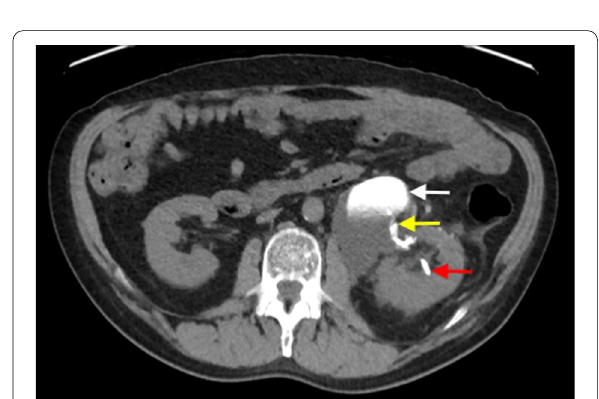
Fig. 3 Delayed excretory phase CT image of contrast extravasation into a urinoma (white arrow) following left ureteric injury during a left partial nephrectomy. The yellow arrow demonstrates the site of active contrast extravasation from the left pelvi-ureteric junction, which was injured during the operation. A nephrostomy catheter (red arrow) was sited to decompress the collecting system and to facilitate urinary drainage. The patient developed persistent pelvi-ureteric junction obstruction and required a completion left nephrectomy